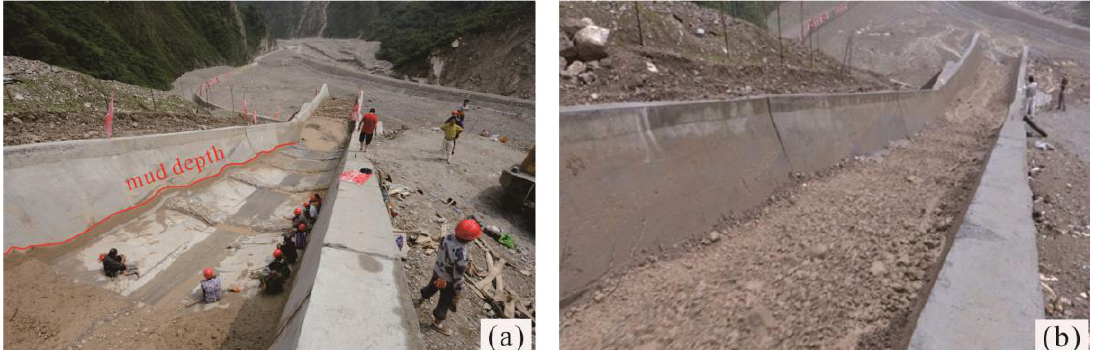
Figure 13. Abrasion at the bottom of the upstream and downstream sections of the channel. ( a ) The steel bar at the bottom of the section B 1 was almost destroyed; ( b ) the section B 3 was only partially exposed.